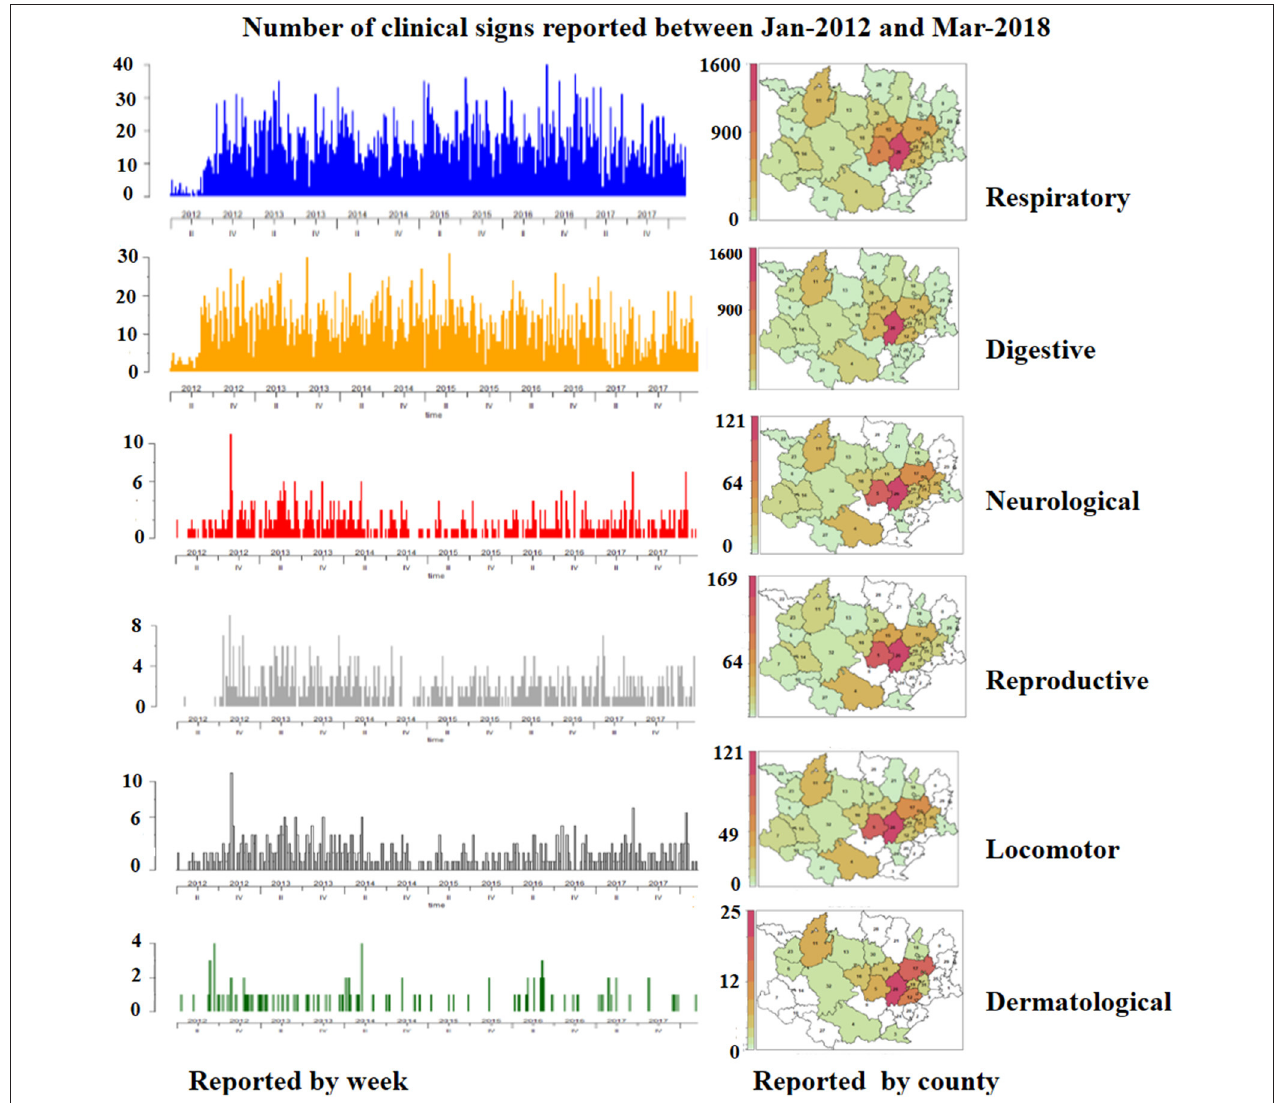
FIGURE 3 | Frequency of clinical signs with their spatiotemporal distribution reported by week and by county in swine farms of Northeastern Spain between January, 2012 and March,